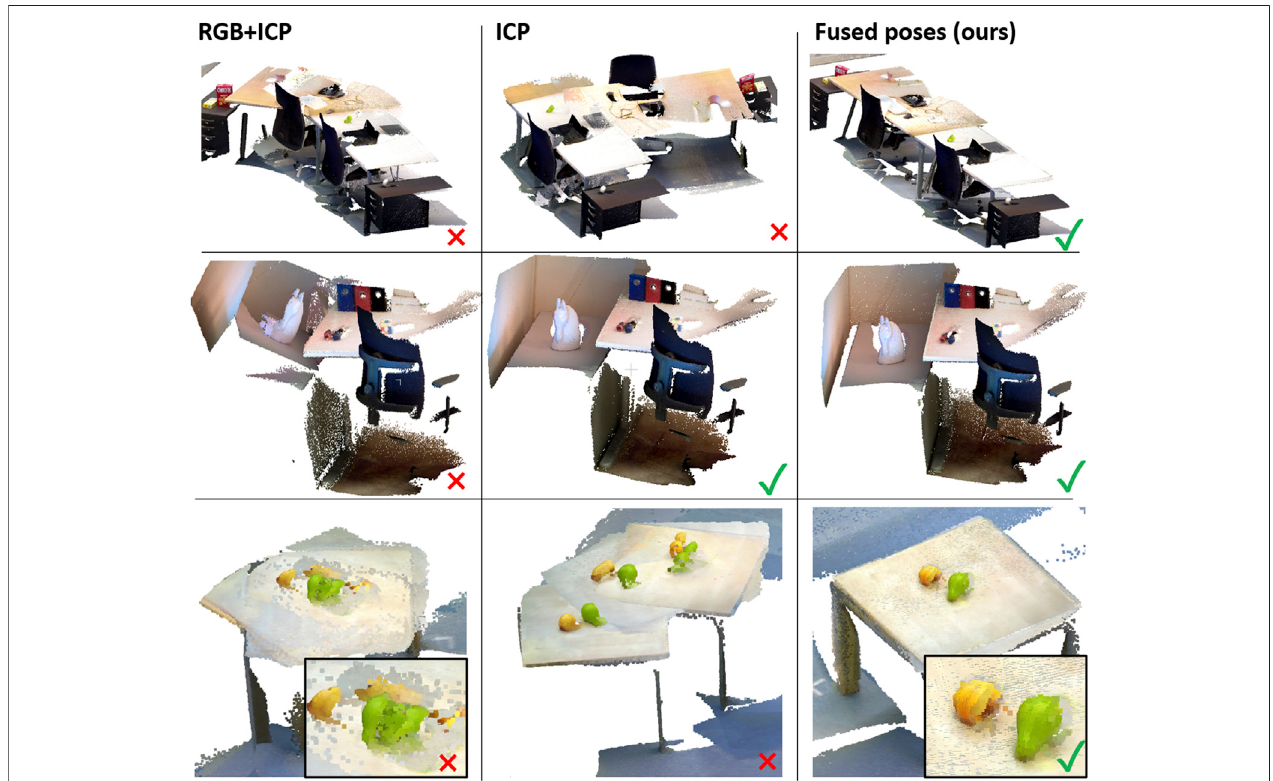
FIGURE 2 | Each row shows a surface of one of the environments in our dataset. The fi rst column is the result of ElasticFusion using RGB and ICP information to estimatethecamerapose,thesecondrowshowsresultsusingonlyICP,andthelastcolumnshowstheresultoffusingtherobotposeswiththeestimatedcameraposes from ElasticFusion (only